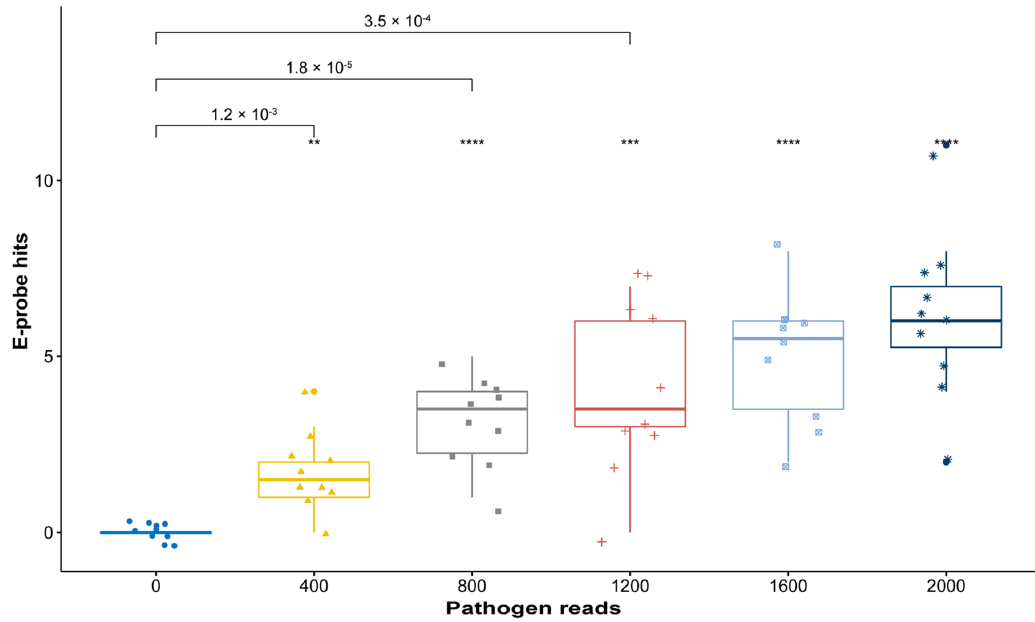
Figure 3. In silico response to increasing pathogen titer (GLRaV-3) with five e-probes. Boxplots depict e-probe hits distribution ( y -axis) vs. a gradient pathogen titer (# reads of pathogen in the metagenome ( x -axis)) in the simulated metagenome. It is observed that a p -value of 0.0012 is still able to distinguish a true positive from a known negative control. Statistical value meanings in the figure are ns: not significant, p > 0.05; **: p ≤ 0.01; ***: p ≤ 0.001 and ****: p ≤ 0.0001. Boxplot colors represent a different pathogen read number in the metagenome and are labeled in the x axis.